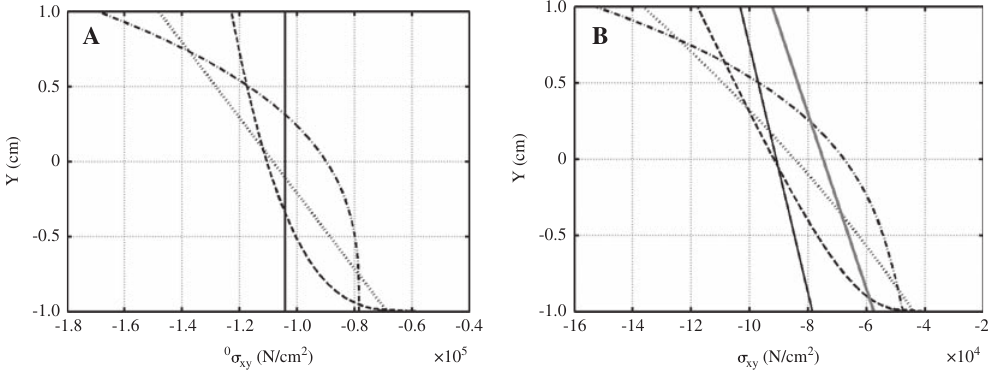
Figure 12 (A) Shear stress distributions in the geometrically linear case. (B) Cauchy shear stress distributions in the geometrically non-linear case for various values of the power-law exponent at fi xed end for q = 500 N/cm 2 . ( – – – – ) Full ceramic, ( – – – ) k = 0.3, (------) k = 1, ( – – – ) k = 3, ( – – – – ) full